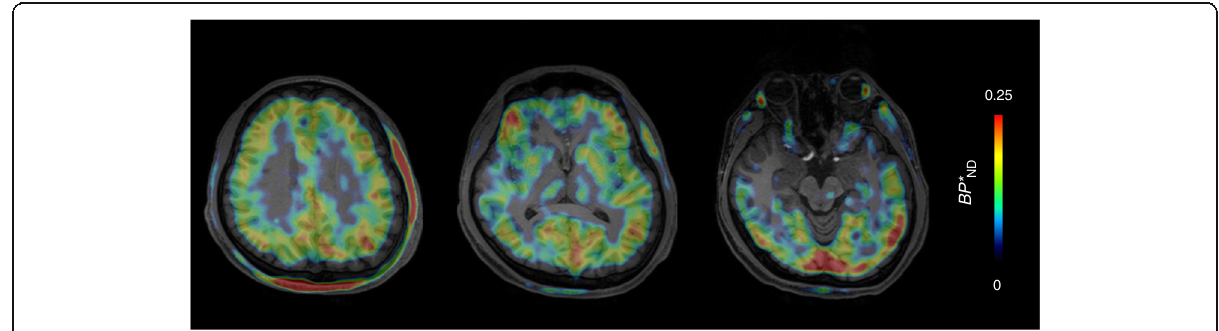
Fig. 7 Parametric images of BP * ND of the subject with lipophilic radiometabolites (NC2) created by voxel-based MRTM O using centrum semiovale as reference